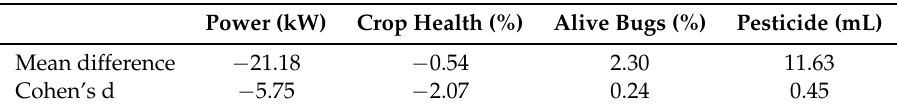
Table 5. Effect sizes between neighbor and low-cost neighbor